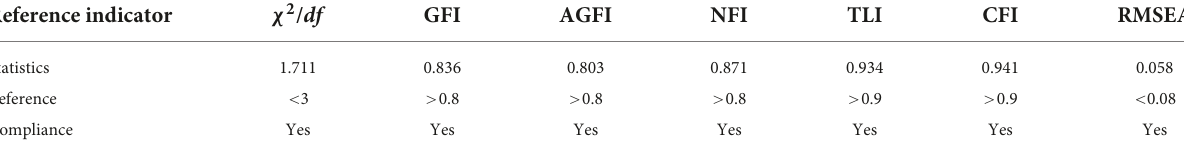
TABLE 5 Model fit indices.